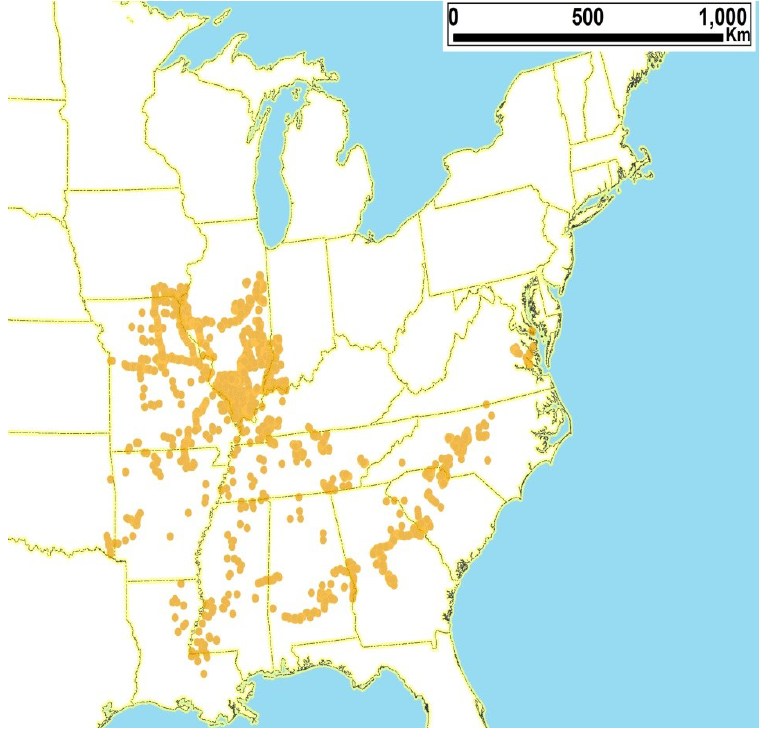
Figure 31. Distribution of the 13-year Magicicada species (gold circles). All species are represented collectively with each location being a single or multiple species. The distribution of individual species follows the patterns outlined in the text.